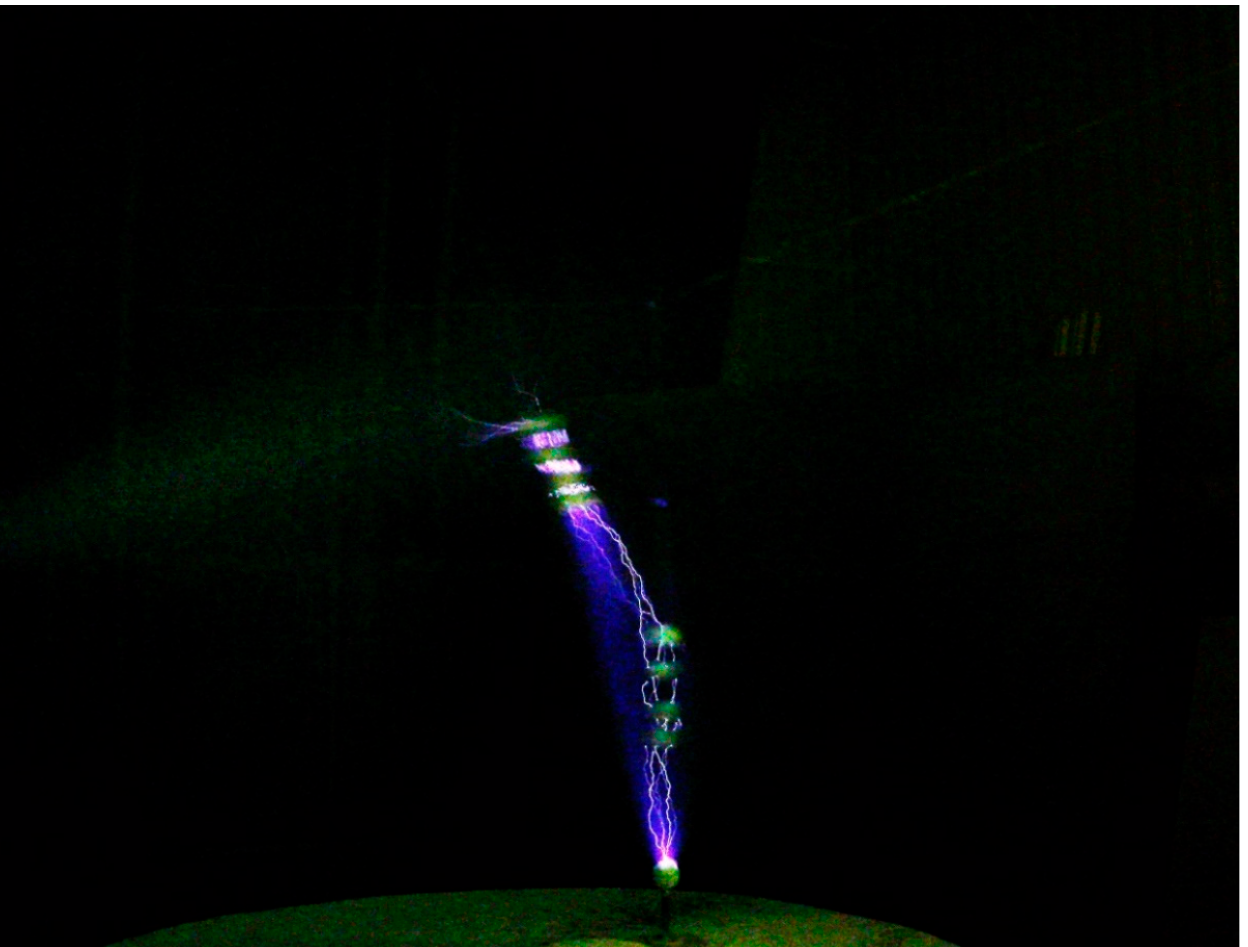
Figure 5. Discharge formation between a single artificial positively charged thunderstorm cell and the ground involving two groups of model hydrometeors.